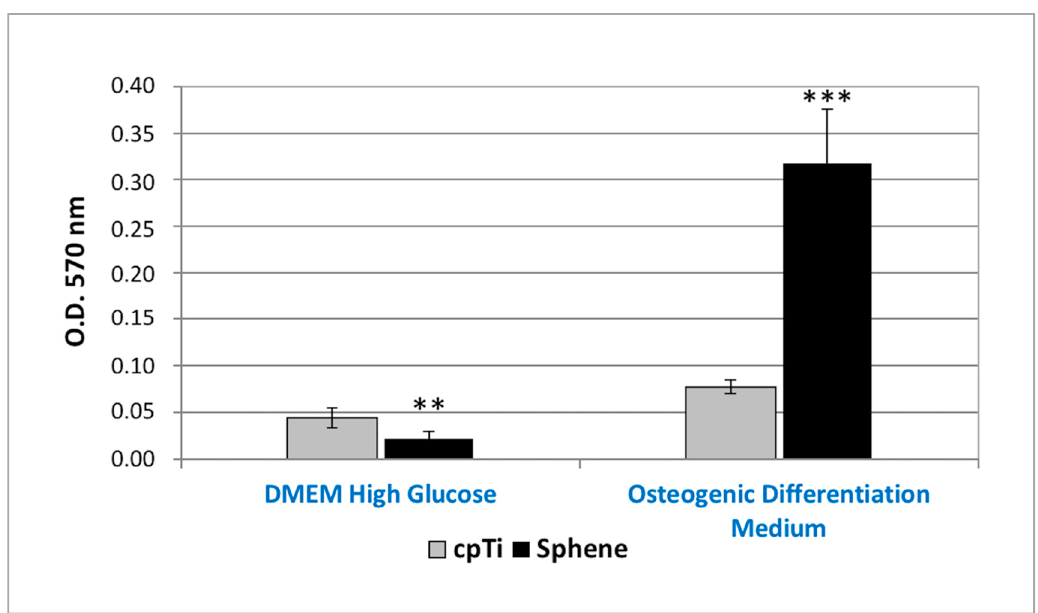
Figure 8. Alizarin Red S quantification of calcium deposits produced by hADSCs seeded onto cpTi or Sphene surfaces in DMEM High Glucose or Osteogenic Differentiation Medium for 21 days. * p < 0.05, ** p < 0.01, *** p < 0.001.